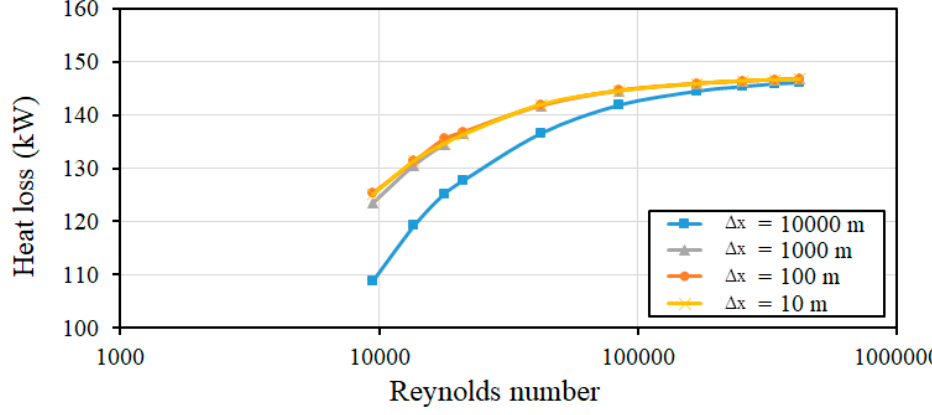
Figure 4. The effect of the grid size on length direction on the accuracy of the results.